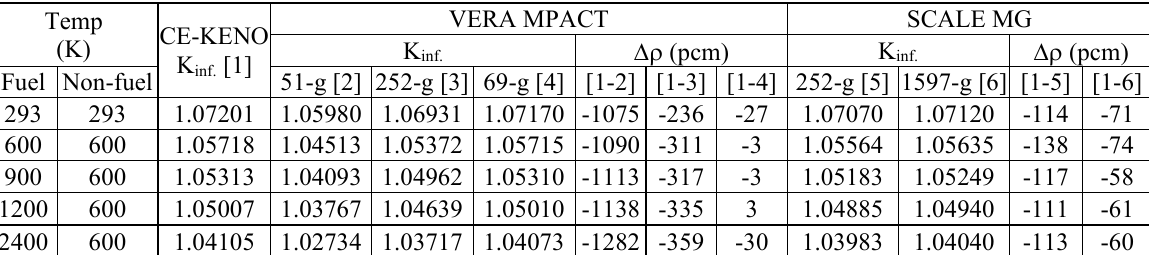
Table III. Comparison of the multiplication factors